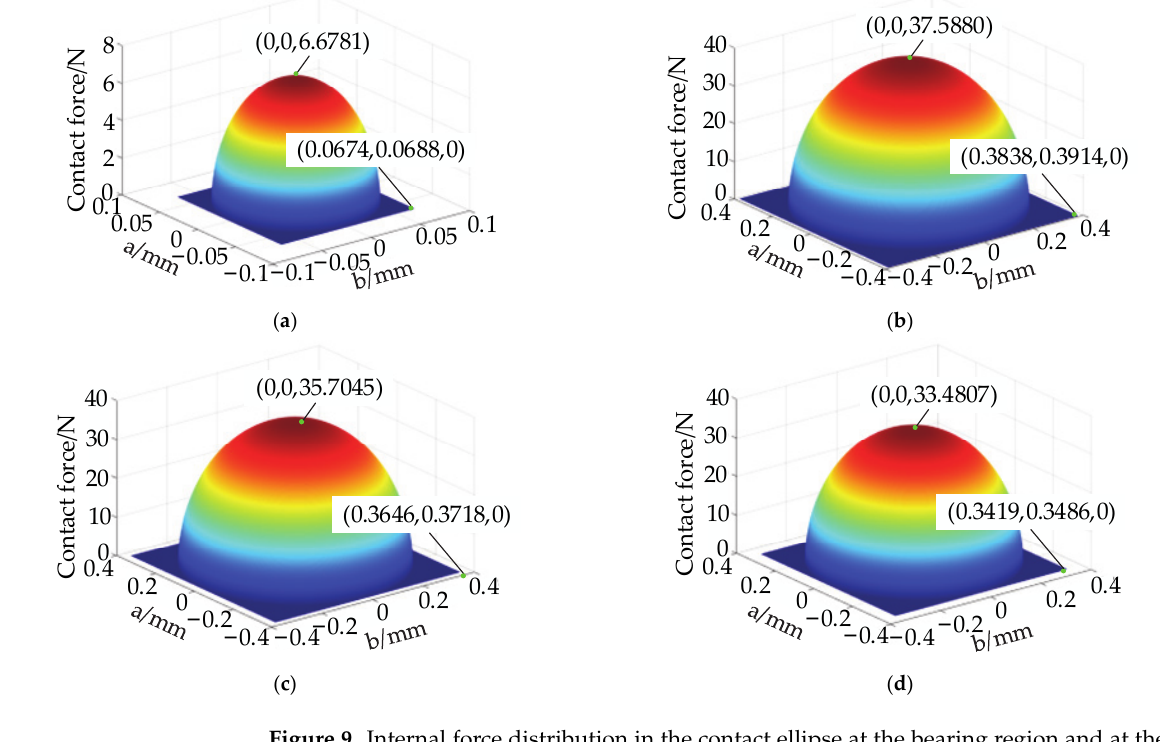
Figure 9. Internal force distribution in the contact ellipse at the bearing region and at the discrete groove: ( a ) rolling element 1; ( b ) rolling elements 2 and 3; ( c ) rolling elements 4 and 5; ( d ) rolling elements 6 and 7.